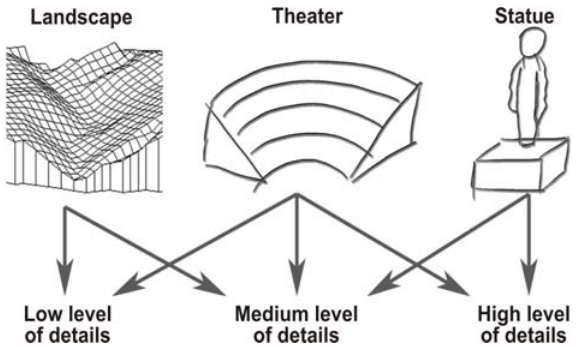
Figure 8. Platform contents at different